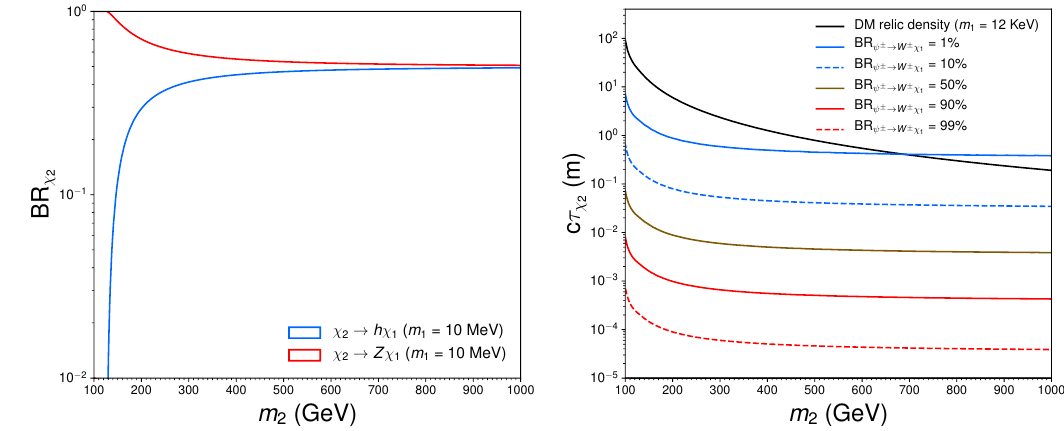
h(cid:31) 1 (blue) and (cid:31) 2 Z(cid:31) 1 (red) as a function of m 2 ! ! plane for a DM W (cid:6) (cid:31) 1 ) values in the ( m 2 , c(cid:28) (cid:31) 2 ! = 0 : 12 for m 1 = 12 KeV as computed (cid:31) h